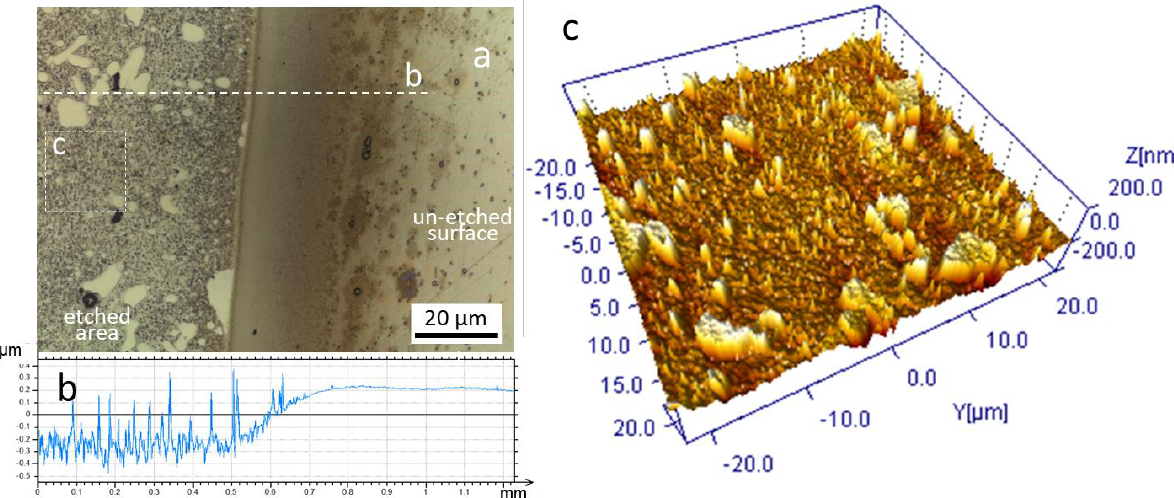
Figure 9. Optical image ( a ) and roughness profile measured along the dashed line ( b ) show the transition from the region exposed to ion etching to the unexposed one (this part of the substrate was covered with a stainless steel foil). Ion etching of D2 substrate was performed in the CC9 deposition system (MF + booster). The etching rate was quantified by measuring the step height between the etched and un-etched surface area ( b ). AFM image ( c ) of ion-etched area of D2 tool steel substrate (scan area was 50 µm × 50 µm).